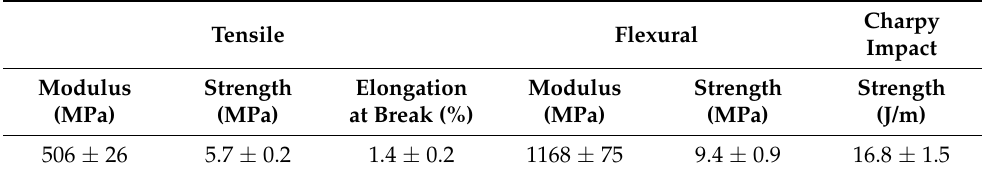
Table 2. Mechanical properties of a sample based on 100% of treated fiber.